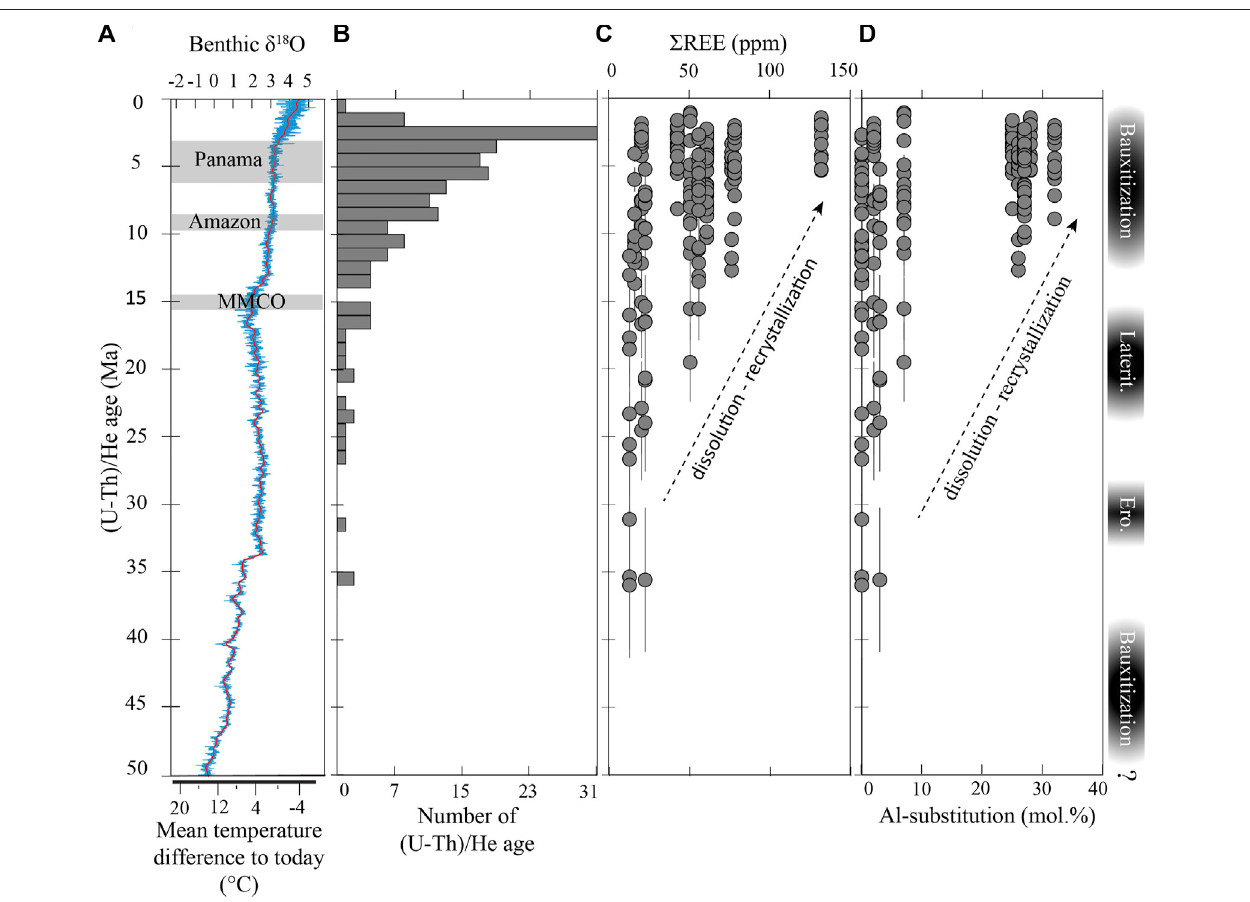
FIGURE 8 | (A) Global evolution of the δ 18 O composition of benthic foraminifera from ocean drill cores and global temperature evolution in comparison to actual meantemperature(Westerhold etal.,2020),withmajorclimatic and/orgeologicalevents:themid-MioceneClimateOptimum ca.15 Ma,theonsetoftheactualAmazon drainage system ca. 9 Ma, and the closure ofthe Panama isthmus ca. 7 – 3 Ma. (B) (U-Th)/Heage distributionofourdataset. (C) Distribution ofbulk REE concentrations of duricrust samples in comparison to (U-Th)/He age of subsamples. (D) Distribution of goethite Al-substitution calculated from bulk XRD spectra according to the (U-Th)/He age of subsample. The main weathering and erosion phases in the Brownsberg area are identi fi ed in the black boxes on the right (Ero., erosion; Laterit., lateritization).